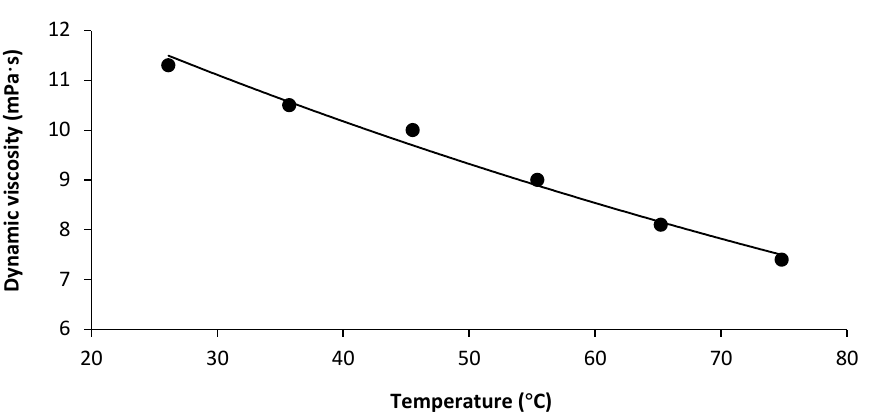
Figure 3. Dynamic viscosity of the ultrafiltration retentate (dry matter = 4.03%) as a function of measuring temperature, determined at a shear rate of 1872 s − 1 .